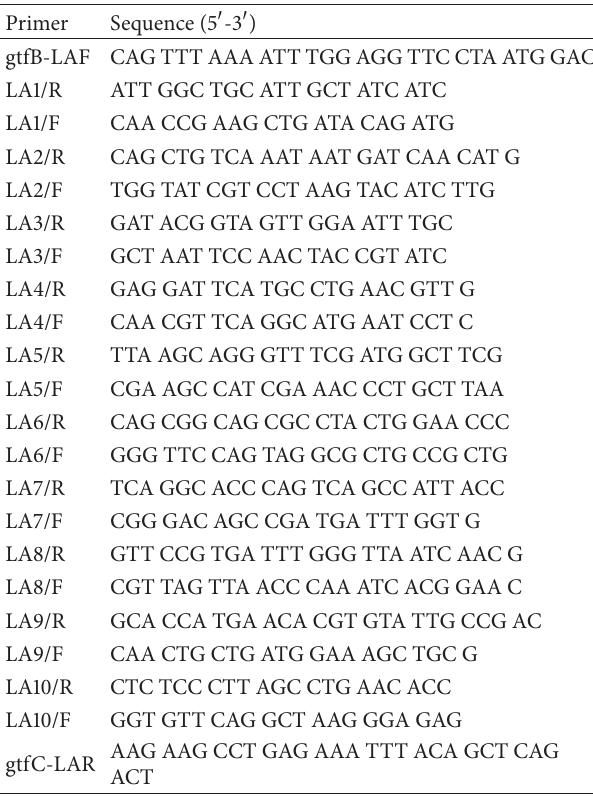
Table 2: Primers used for determination of nucleotide alignment of gtfB - gtfC